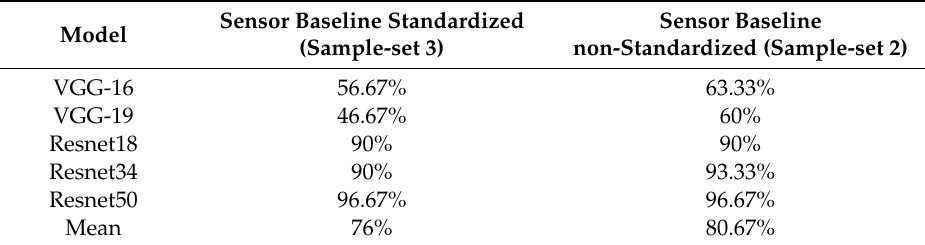
Table 11. Test accuracy for di ff erent classification